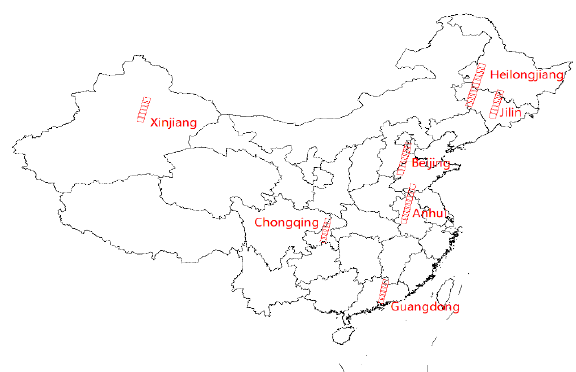
Figure 4 . Distribution of seven calibration fields